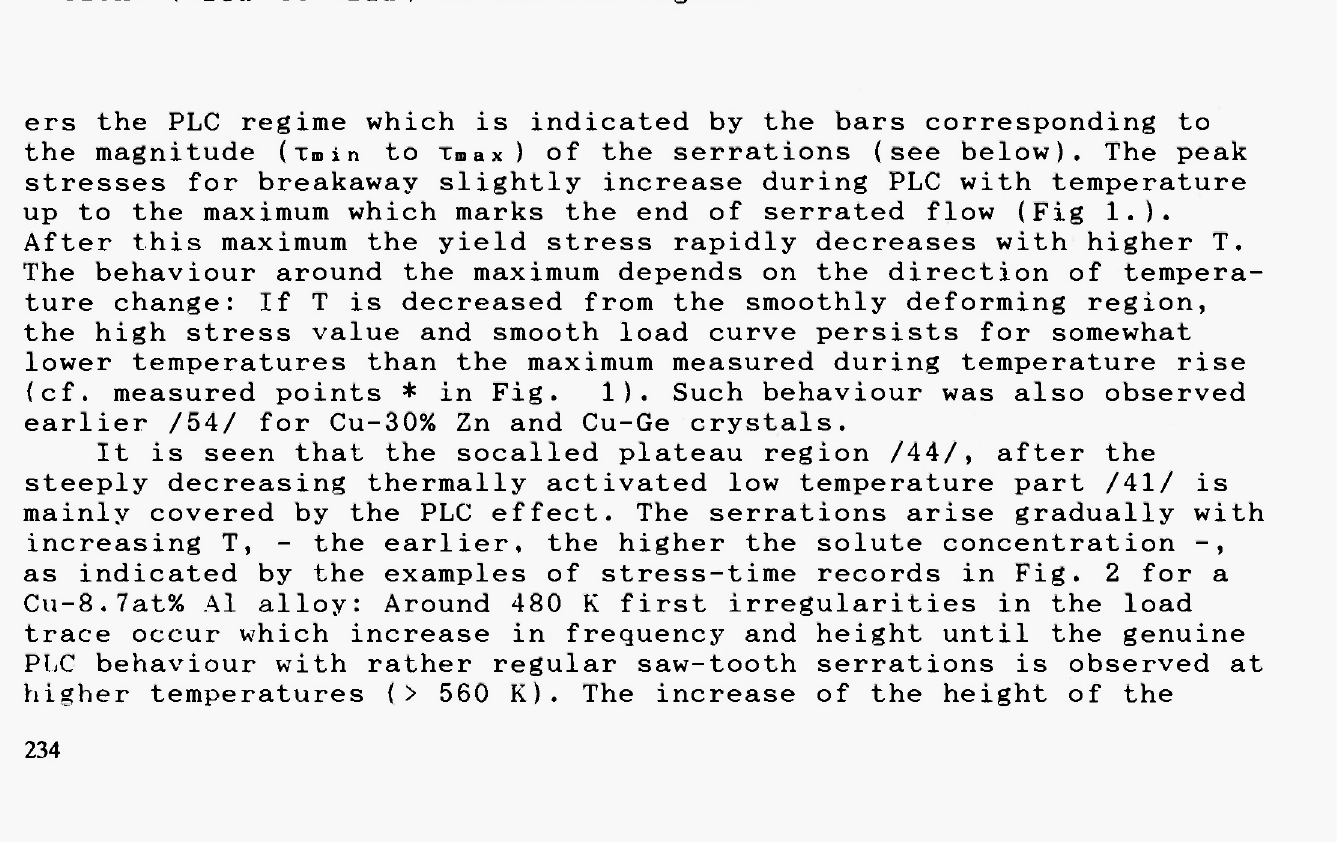
Fig.1 Temperature dependence of the critical resolved shear stress in stage I (cf. text) for Cu-2, -5, -10, and -15 at% Al single crystals. (•) from Suzuki /42, 43/, e = 2.2*10- 4 s" 1